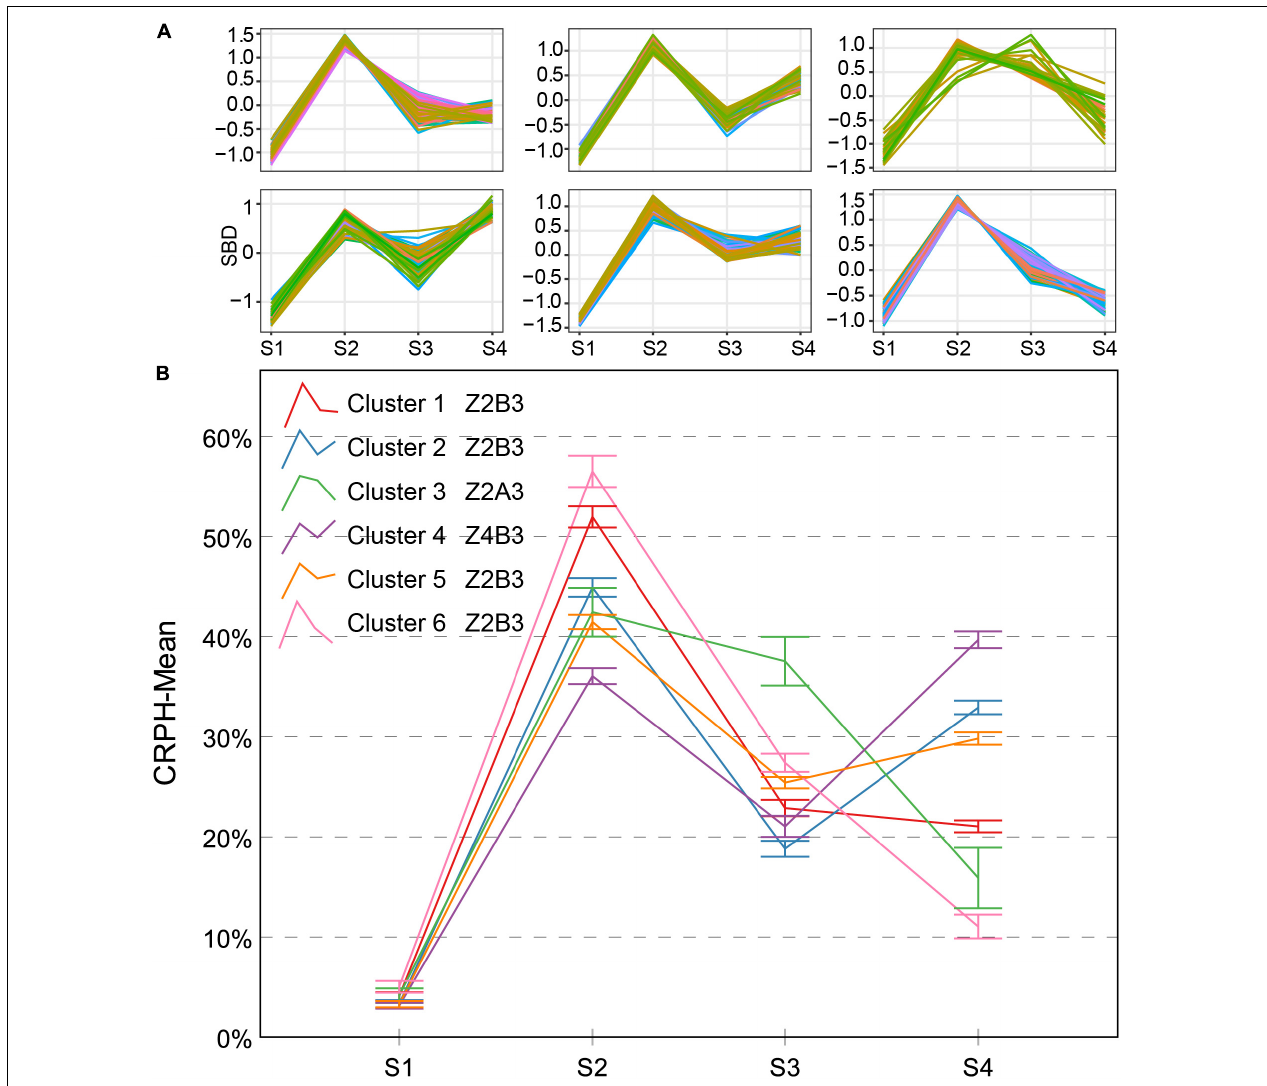
FIGURE 10 | Clustering analysis for CRPH time series (A) and six clusters and typical curve for CRPH trait (B) . (A) The horizontal X -axis represents four growth stages, and the vertical Y -axis represents the shape-based distance. (B) The horizontal X -axis represents four growth stages, and the vertical Y -axis represents the mean value of AGRPH at a specific growth stage. Zenith point all lies at the S2 growth stage and its adjacent point lies at the S3 growth stage except cluster 4. Typical curves are based on mean values with a 95% confidence interval. CRPH, contribution rate of plant height; SBD, shape-based